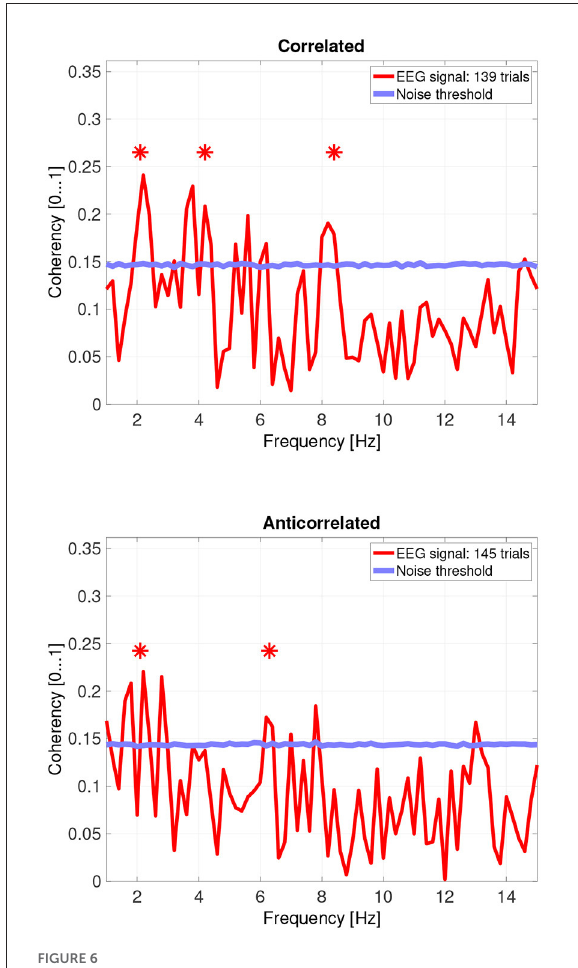
FIGURE6 Coherency values from participant SA. The stars above the peaks indicate successful detection of the harmonic of the stimulus frequency. Note that the coherency plots are in phase space, and that they are not showing spectrum: a higher coherency value imply a stronger relationship to the stimulus. The “Noise threshold” is created with 10,000 data sets having the same number of trials, with the trials containing only white noise. The line shows the 95 th percentile of the coherency values created from these synthetic data sets.